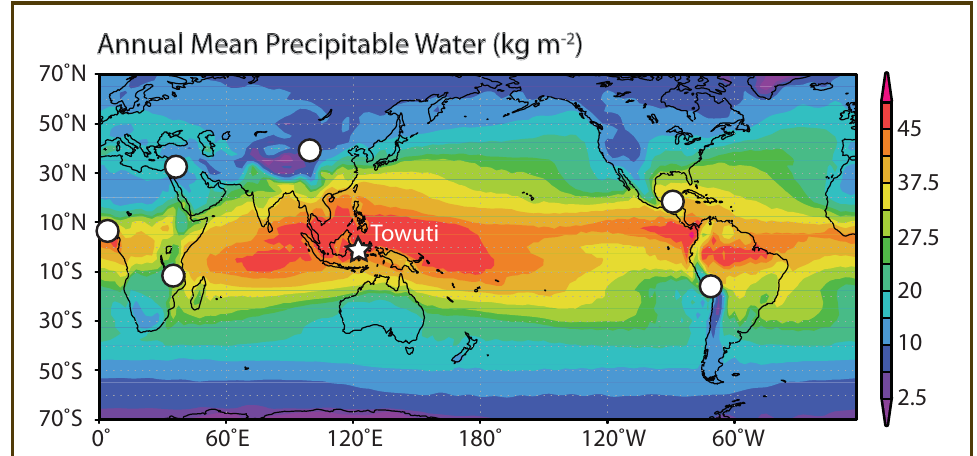
Annual Mean Precipitable Water (kg m -2